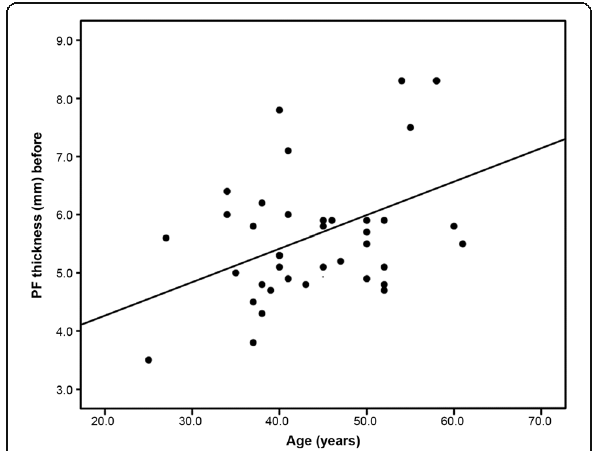
Fig. 3 Correlation between plantar fascia thickness before ESWT and VAS on awakening